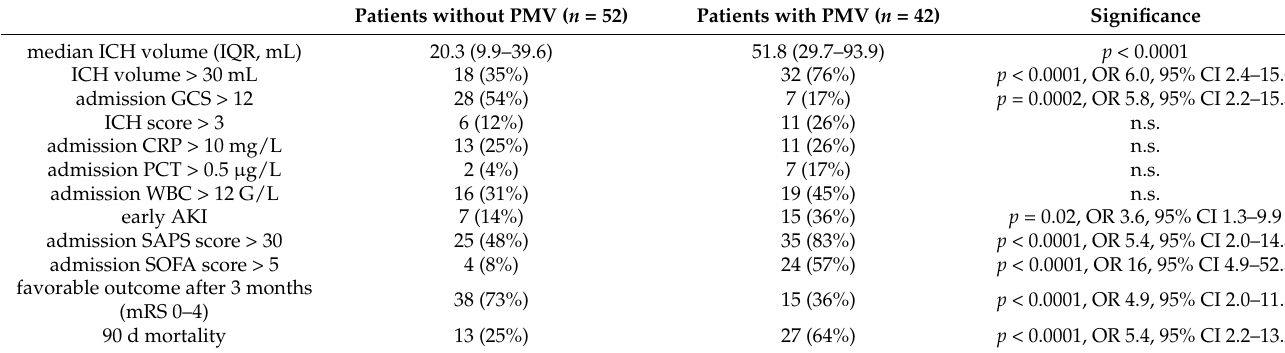
Table 2. ICU admission parameters and outcome.